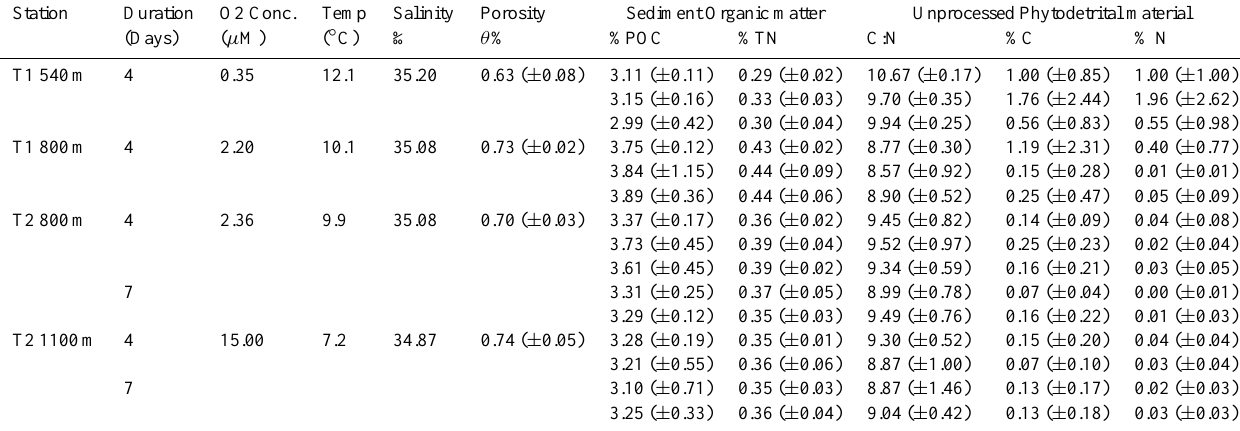
Station O2 Conc.